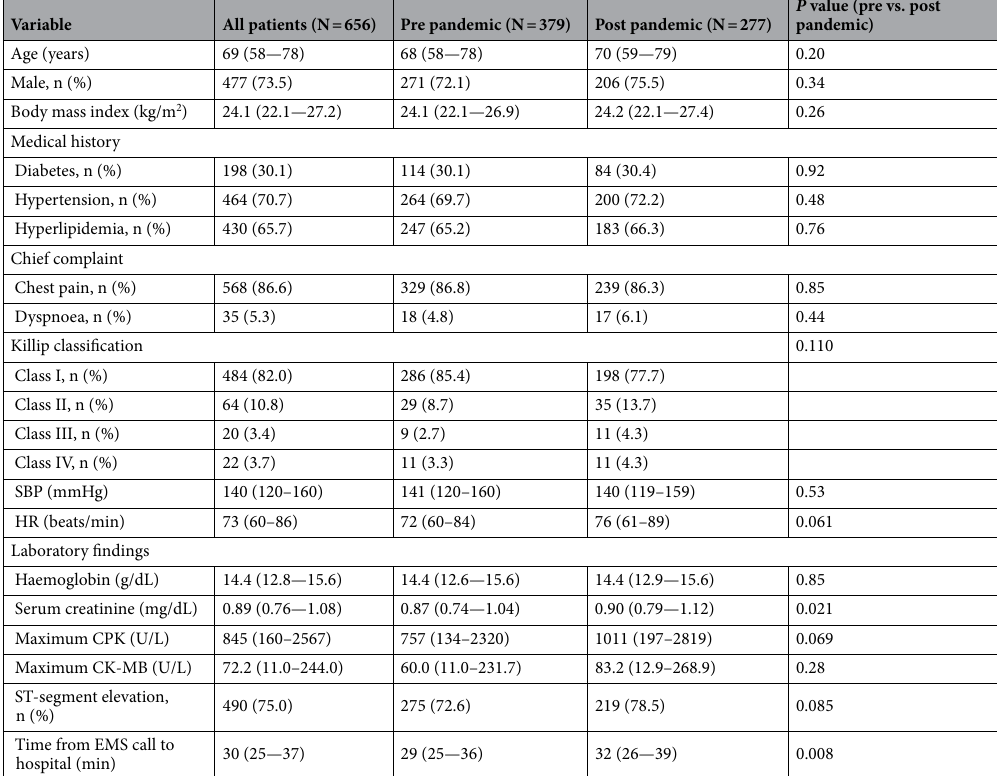
Table 1. Baseline patient characteristics. Continuous variables are presented as mean ± standard deviation if normally distributed, and median (interquartile range) if not normally distributed. Categorial variables are presented as number of patients (%). CK-MB creatine kinase and its MB isoenzyme, CPK creatine phosphokinase, EMS emergency medical services, HR heart rate, SBP systolic blood